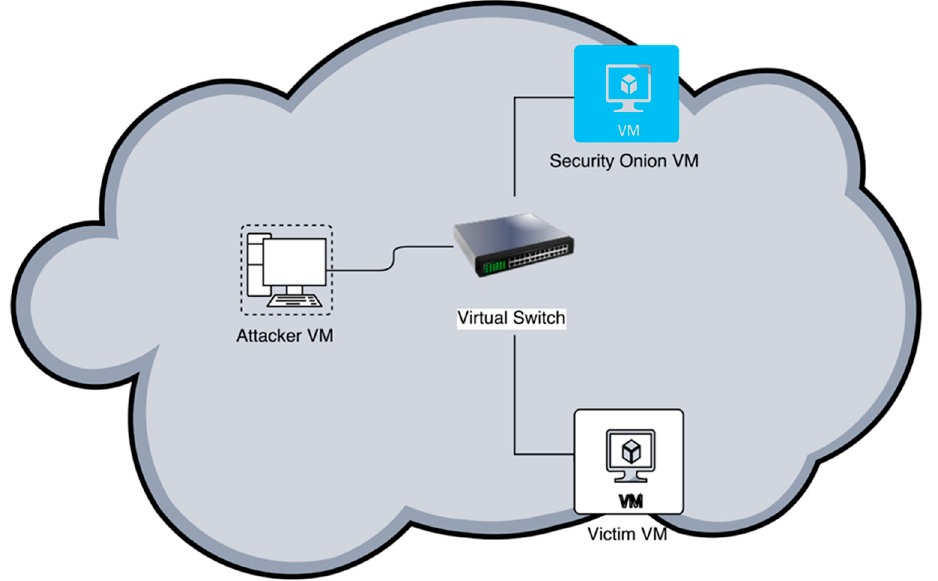
Figure 3. Experimental Setup.